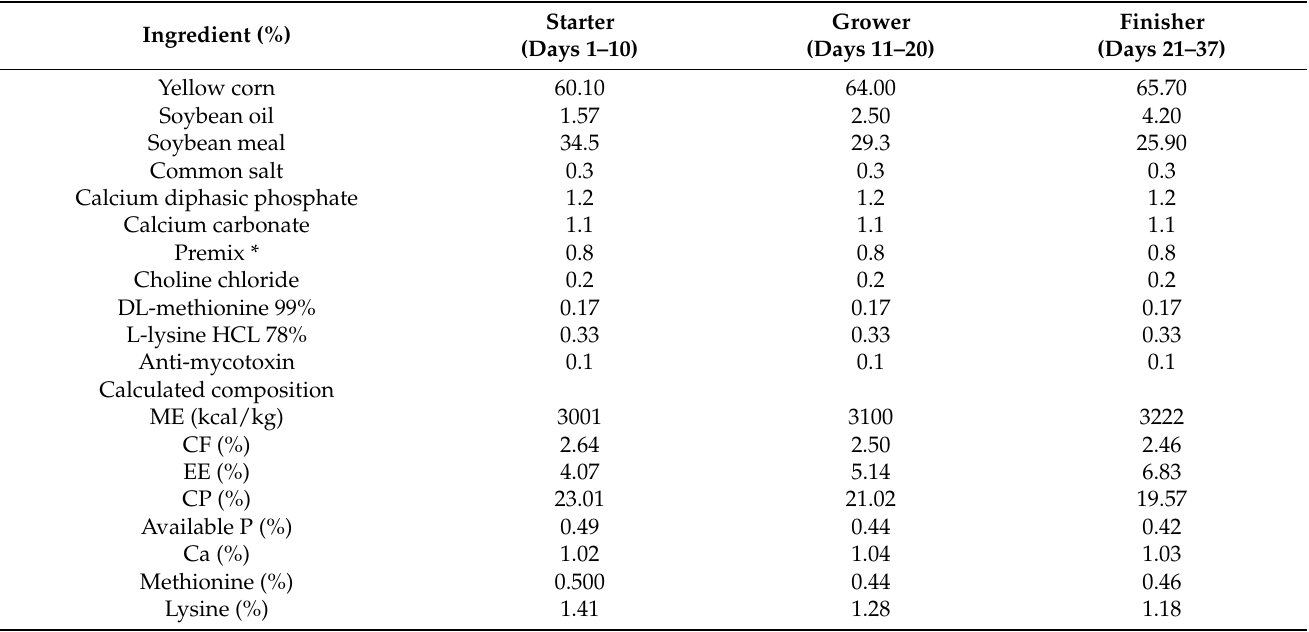
Table 2. Ingredients and nutrient composition of the basal